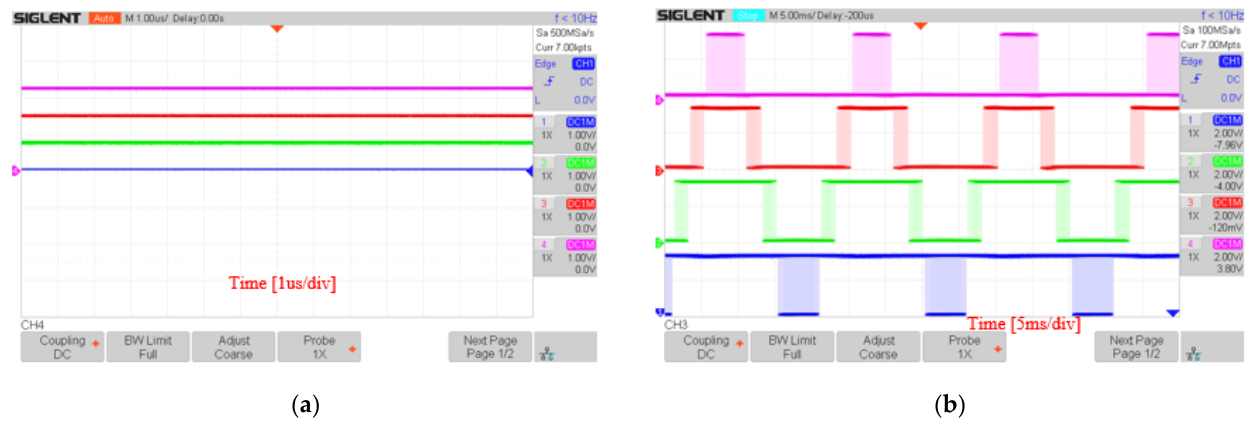
Figure 39. Experimental result of four interleaved carriers using DSA-LSC method, ( a ) carrier levels; ( b ) PWM control signals.